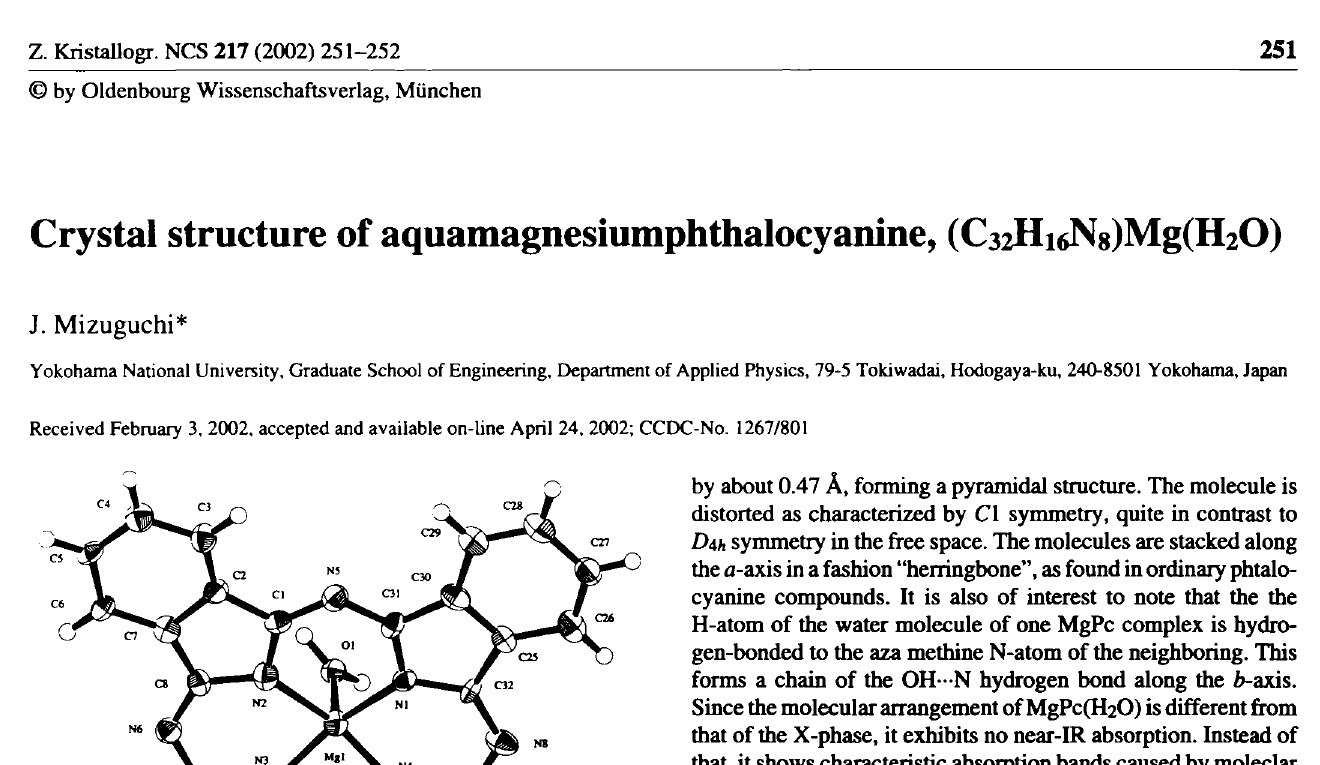
Table 1. Data collection and handling.